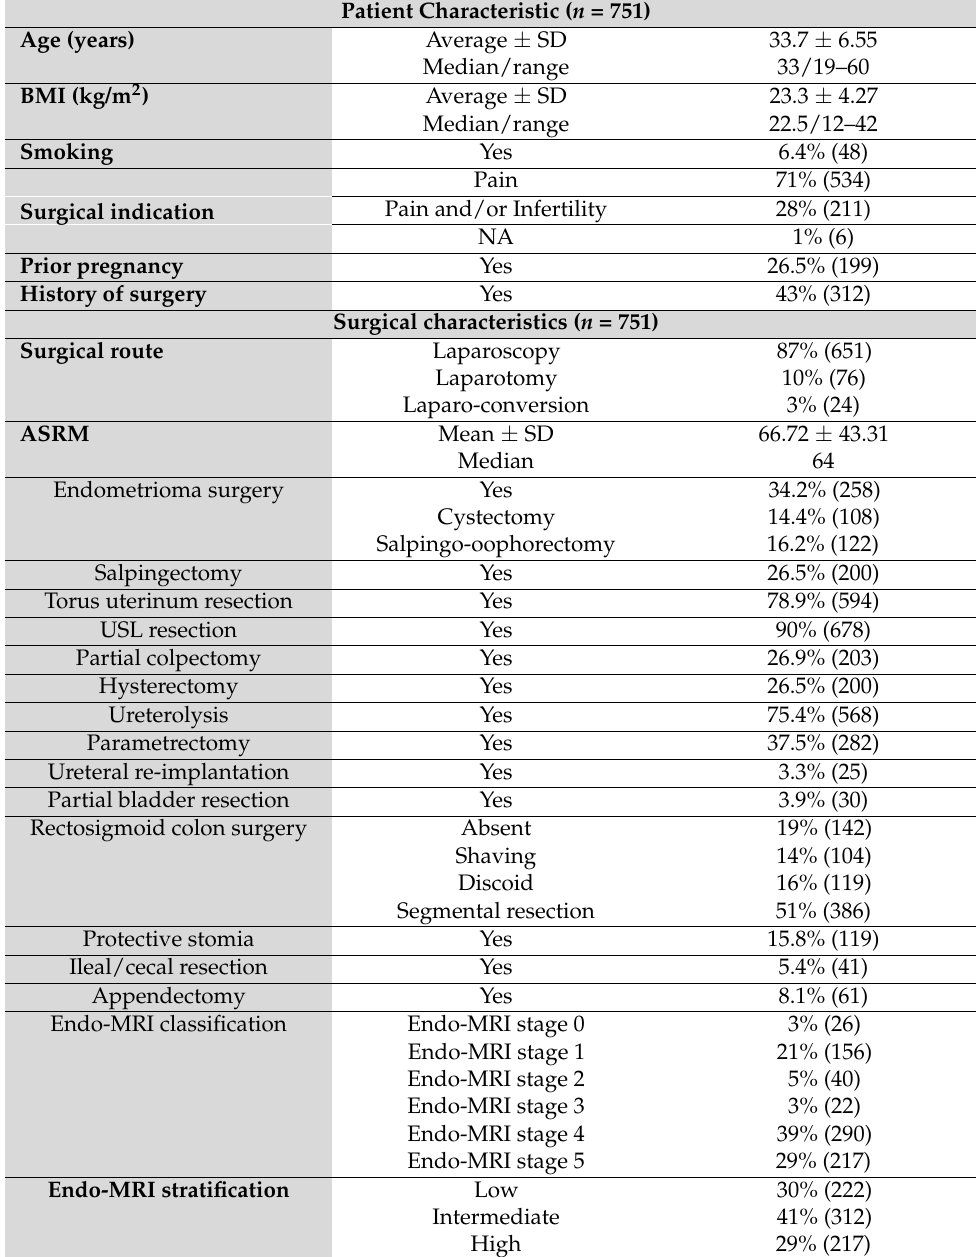
Table 3. Patients, surgical and MRI